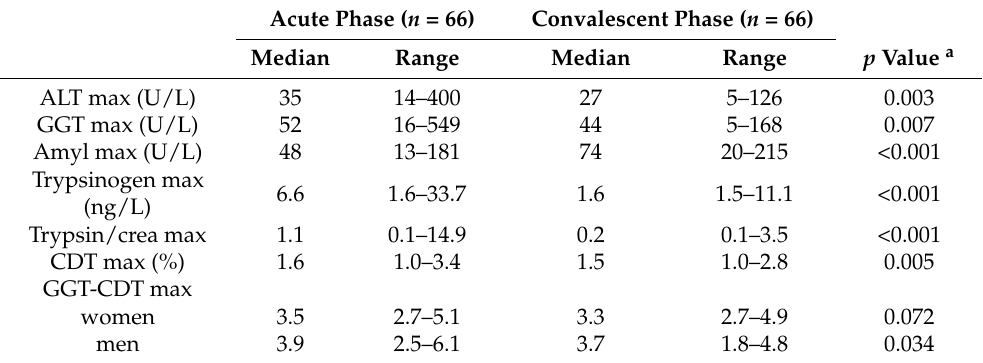
Table 2. Comparison of acute-phase values and control values. Control samples were taken at the median of 24 (range 17–76) days after the onset of